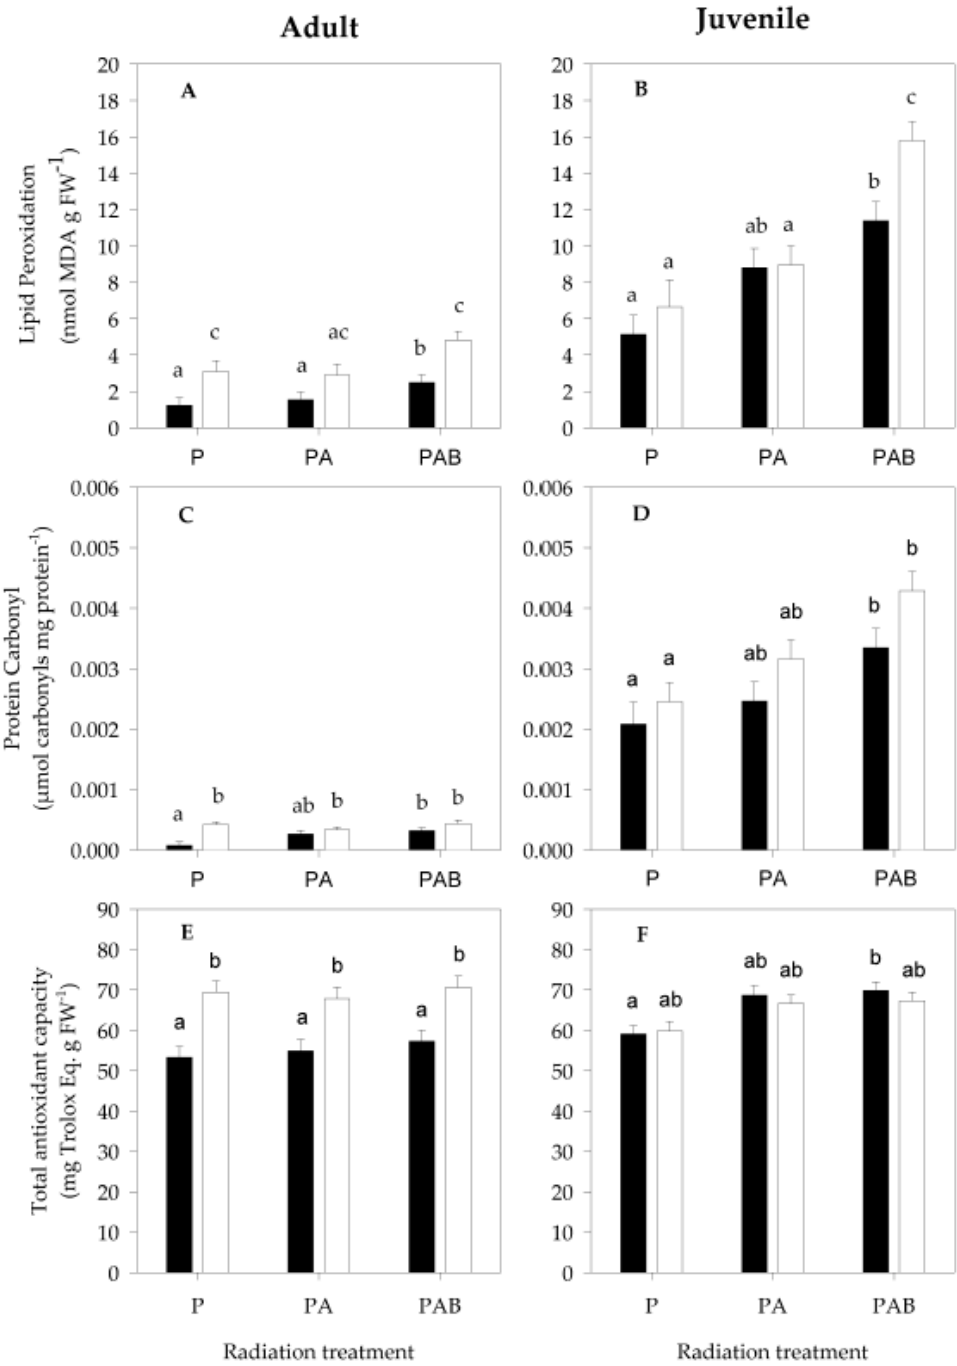
Figure 4. Protein carbonyl ( A , B ), lipid peroxidation ( C , D ) and total antioxidant capacity ( E , F ) in adults and juveniles of the anemone A. hermaphroditica exposed to P (PAR), PA (PAR + UVA) and PAB (PAR + UVA + UVB) radiation treatments with sediment (black bars) and without sediment (white bars). Error bars indicate ±SE. Different letters over bars indicate significant differences ( p < 0.05).